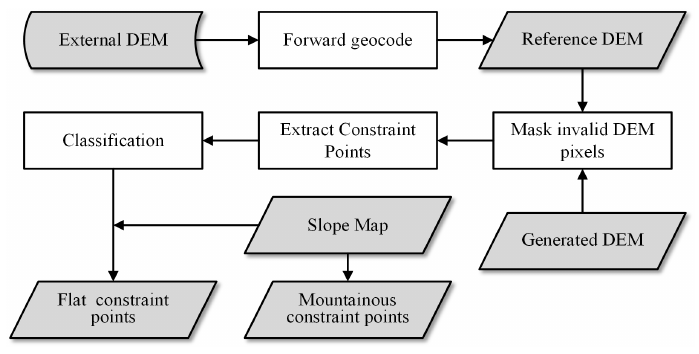
Figure 4. Extraction of Constraint Slices using external public